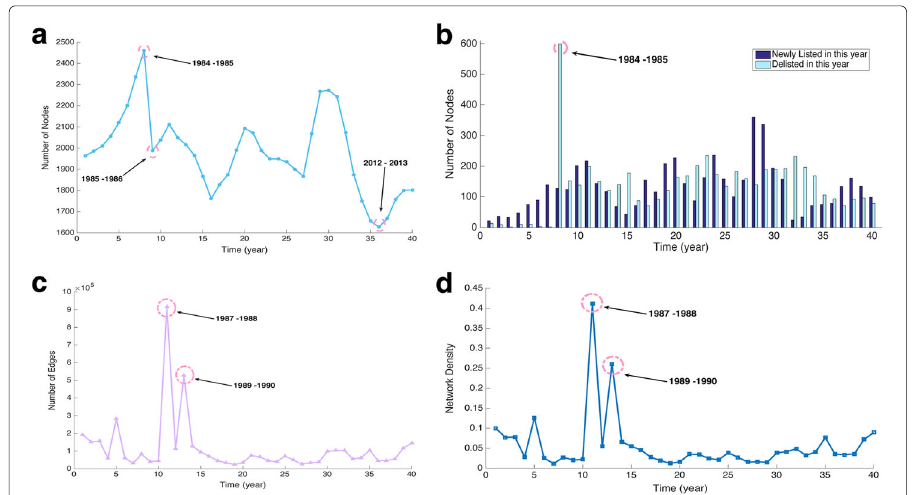
Fig. 1 Evolution of network attributes in time. a number of nodes, b number of newly listed and delisted nodes, c number of edges and d density of the